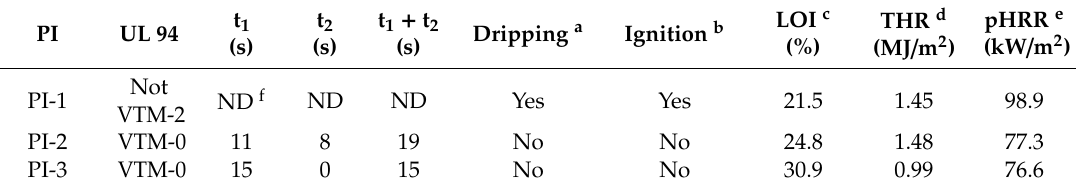
Table 3. Combustion data of PI composite films.